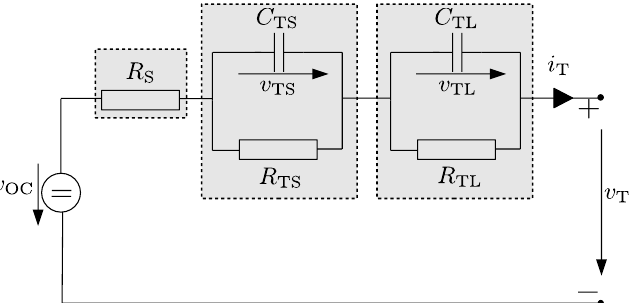
Figure 1. Equivalent circuit model of a Lithium-ion battery in which a series connection of two RC sub-networks is used to represent lag phenomena in the charging and discharging